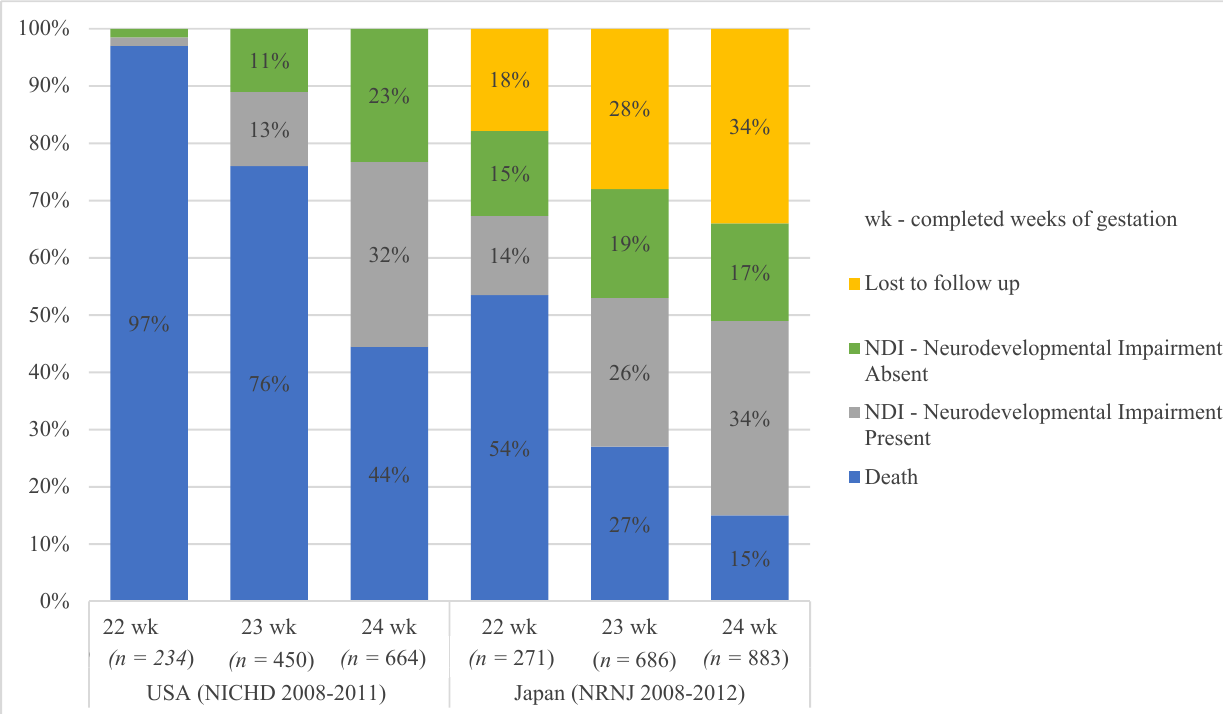
Figure 1. Outcome reports from multicenter databases.